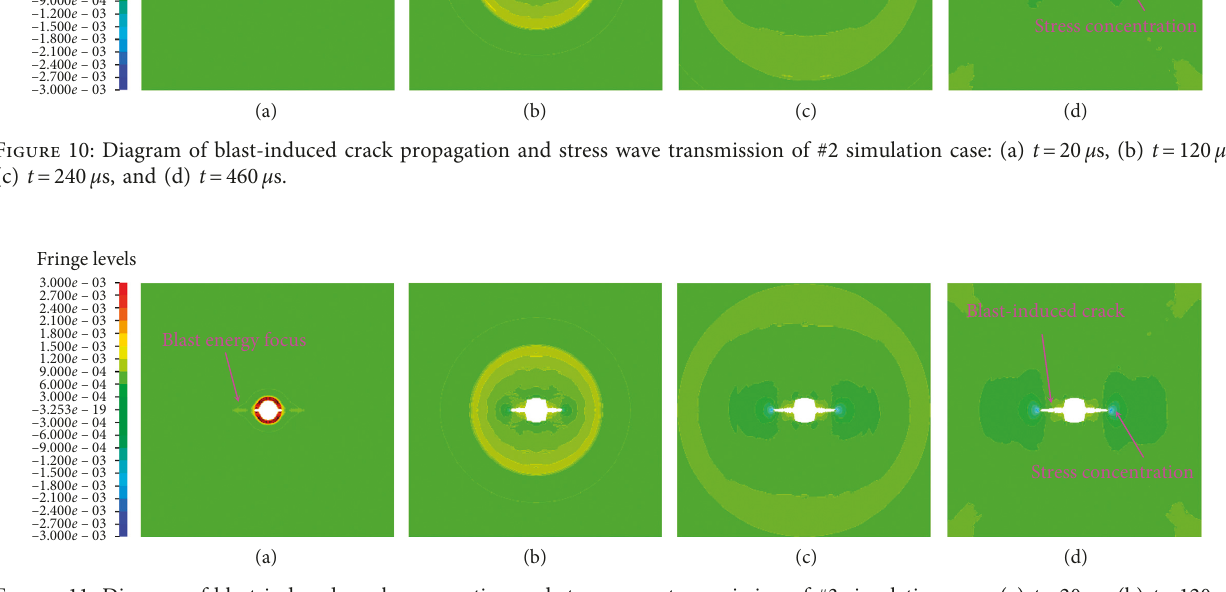
Figure 11: Diagram of blast-induced crack propagation and stress wave transmission of #3 simulation case: (a) t � 20 μ s, (b) t � 120 μ s, (c) t � 240 μ s, and (d) t � 460 μ